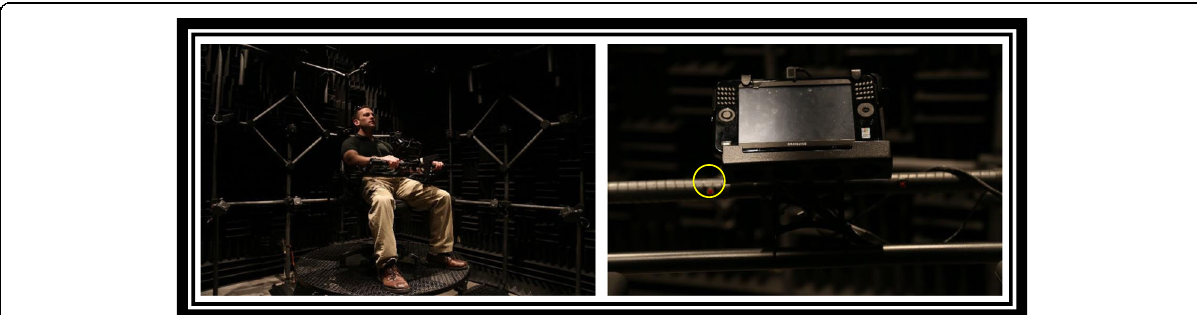
Fig. 1 Left panel depicts a listener seated in the center of the speaker array in the sphere room at the Environment for Auditory Research. The elevated platform allows for the listener to be centered within a ring of speakers positioned every 22.5°. The panel on the right depicts the micro PC used to present trial information to the participant. Participants responded using the red buttons mounted to the handle bar (positioned to the immediate left and right of the micro PC, highlighted in the yellow circles in the image at right